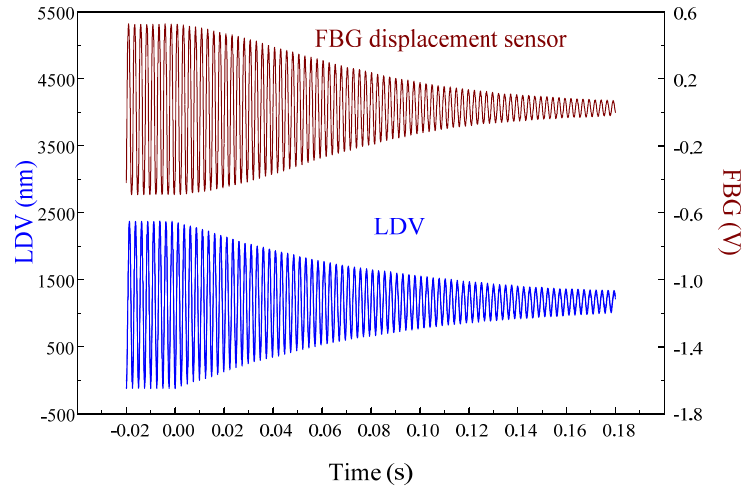
Figure 28. Active vibration control of the smart cantilever beam excited at second resonant frequency (400 Hz) obtained from FBG displacement sensor.